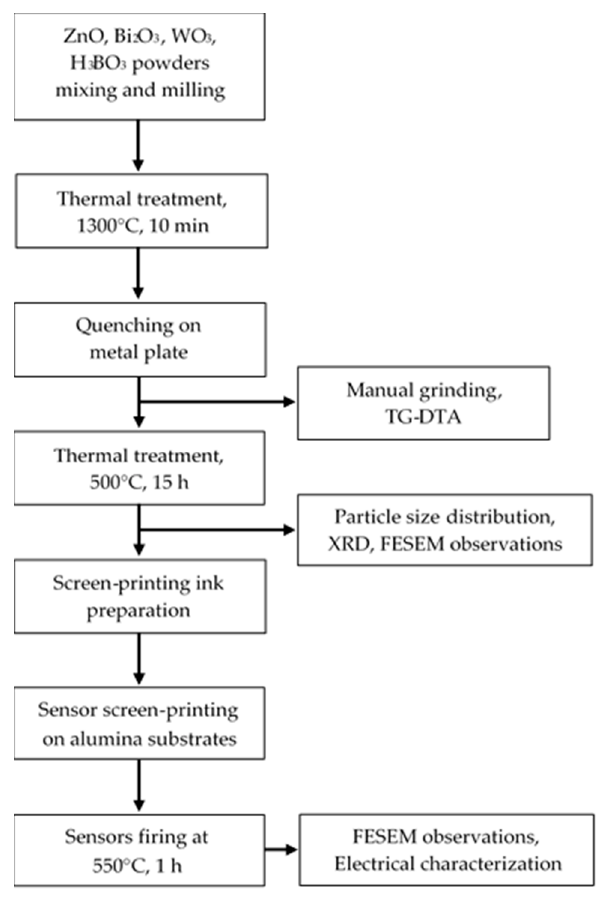
Figure 1. Flow-chart of the sensing material and of the sensors preparation and characterization.